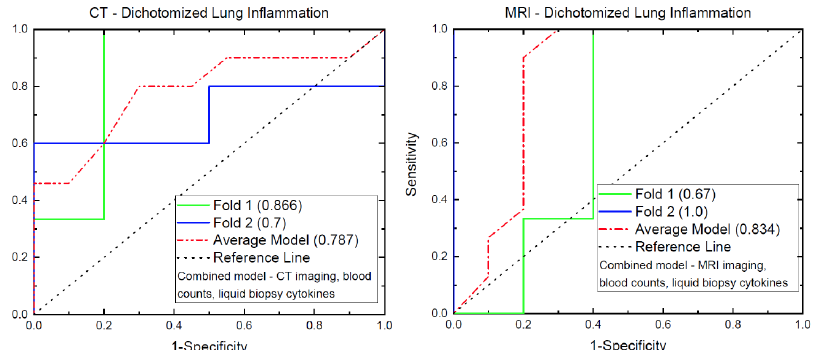
Figure 4. ROC analyses results from the modeling of lung inflammation. The corresponding AUCs for the two models are presented in the parenthesis in the caption. The green and the blue lines represent the ROCs from the two validation folds, while the red line is from the average of the two folds. The corresponding AUCs for the folds and the average are presented in the parenthesis.